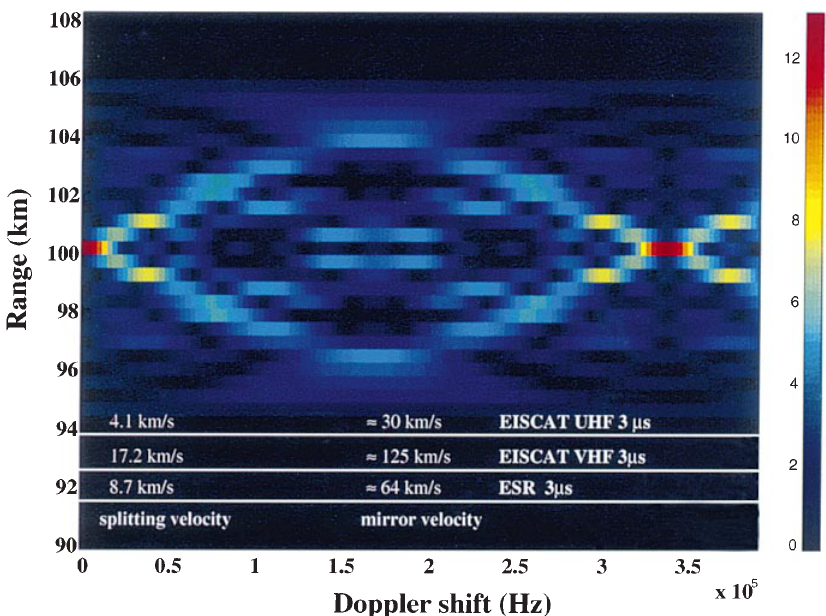
Fig. 7. The power domain response of a matched-filter decoded radar echo from a moving point target, centered at 100 km range and illumi- nated by a 13 · 3 l s Barker code. The splitting velocity is the velocity at which visible splitting of the ordinary ambiguity function can first be de- tected. The response shape mirrors at the so-called mirror velocity. Splitting and mirror velocities for the EISCAT UHF, VHF and Svalbard radars